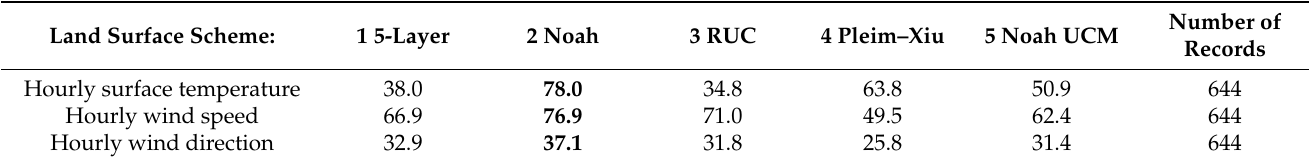
Table 6. Percentages of the records that were captured by modeling. Meteorological variables. Bold numbers highlight the schemes with the best performances.